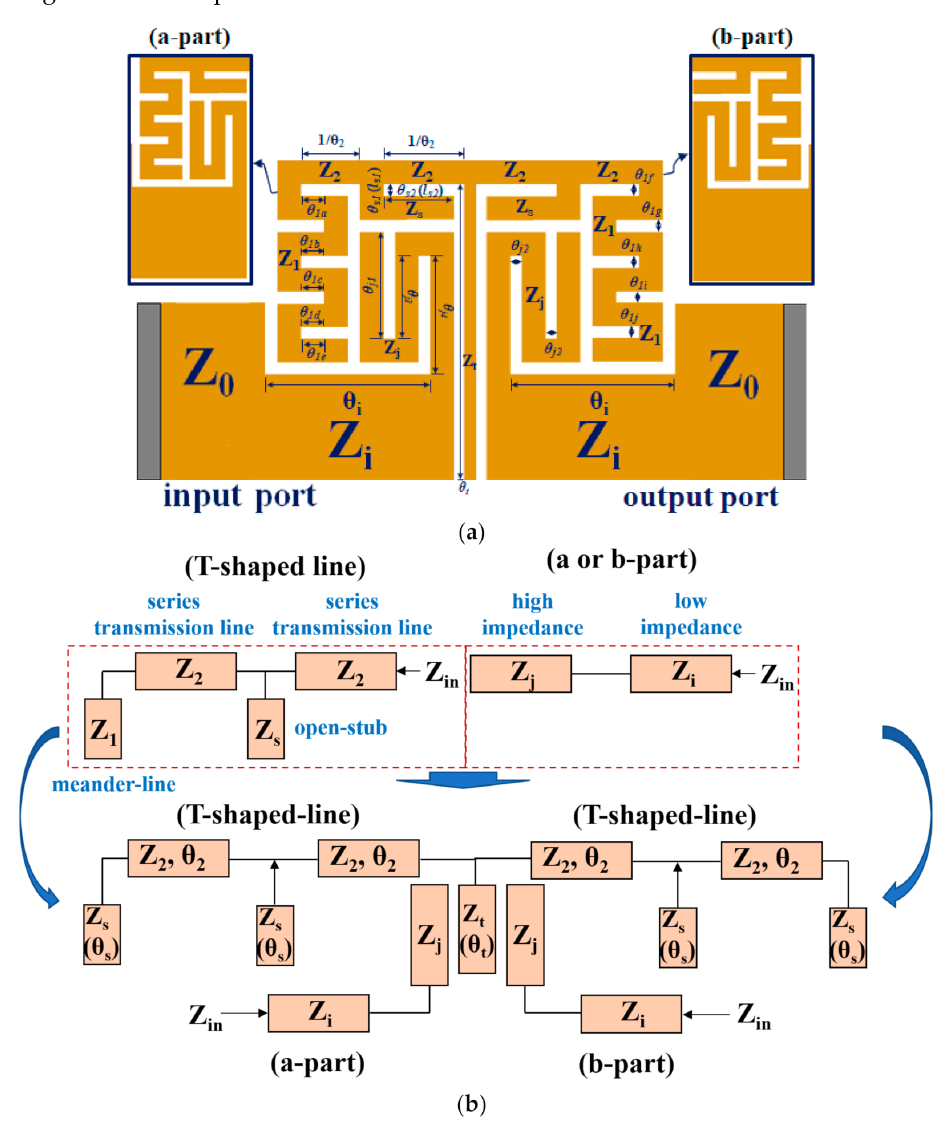
Figure 1. ( a ) Structure and ( b ) equivalent circuit of proposed